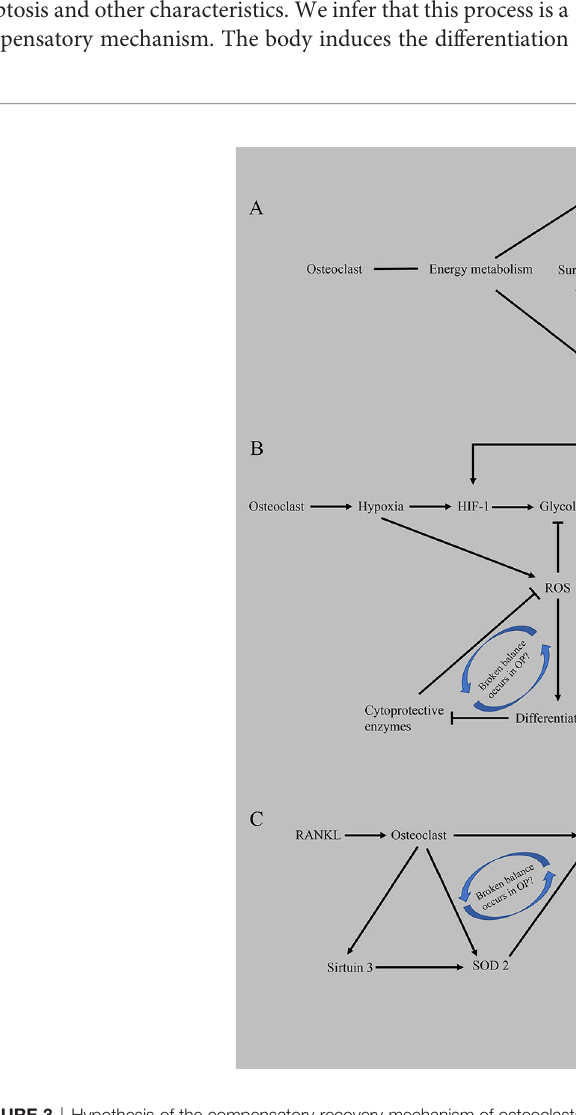
FIGURE 3 | Hypothesis of the compensatory recovery mechanism of osteoclasts. (A) Based on proapoptotic BIM and anti-apoptotic BCL-xL, an imbalance between osteoclast survival and bone resorptive capacity occurs in OP. (B) The disruption of homeostasis between the enhancement of bone resorption activity mediated by hypoxia and the inhibition of ROS on the survival of osteoclasts promotes the occurrence of osteoporosis. (C) RANKL-mediated oxidative stress results in an imbalance between osteoclast survival and bone resorption capacity. ATP, adenosine triphosphate; BCL-xL, B-cell lymphoma-extra large; BIM, BCL-2-like protein 11; HIF-1, hypoxia-induced factor-1; OP, osteoporosis; ROS, reactive oxygen species; RANKL, receptor activator of nuclear factor kappa-B ligand; SOD2, superoxide dismutase